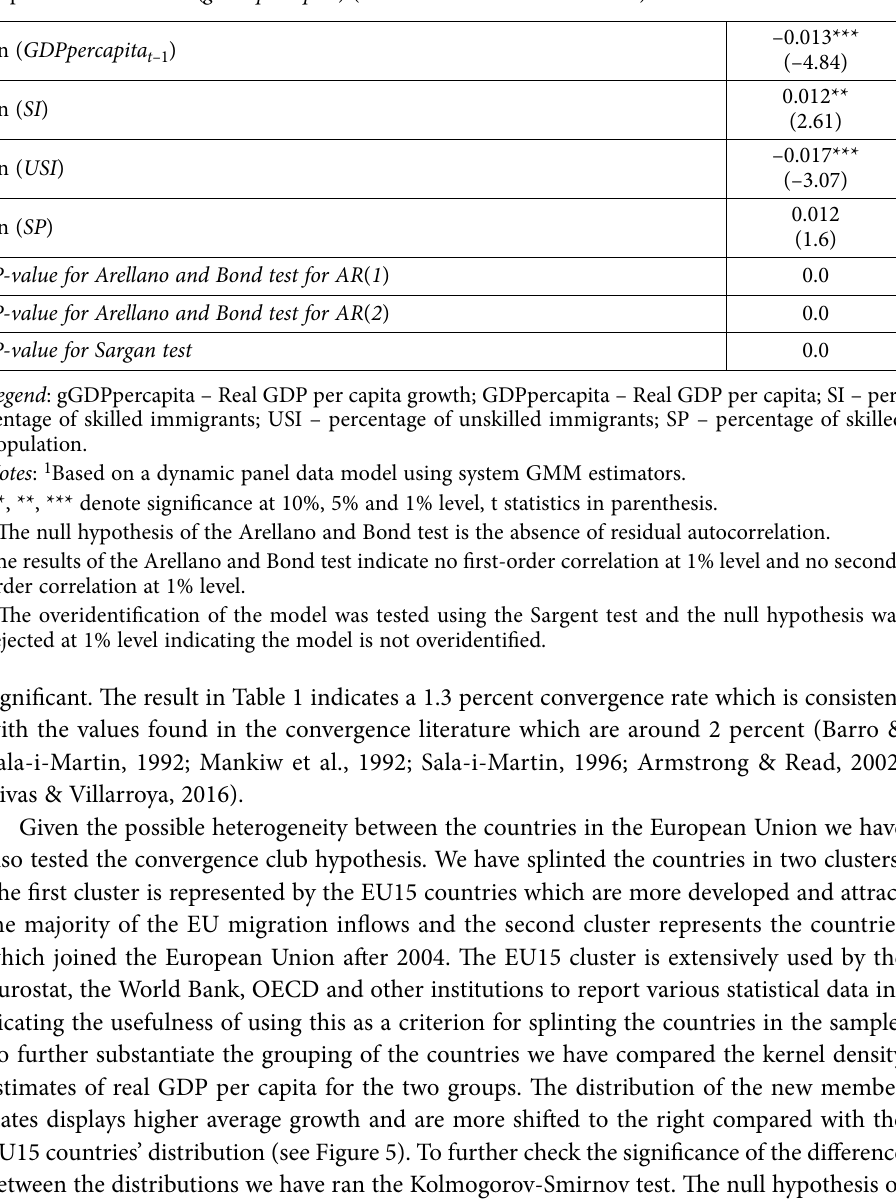
Table 1. Testing the impact of skilled and unskilled immigration on growth based on a dynamic panel model